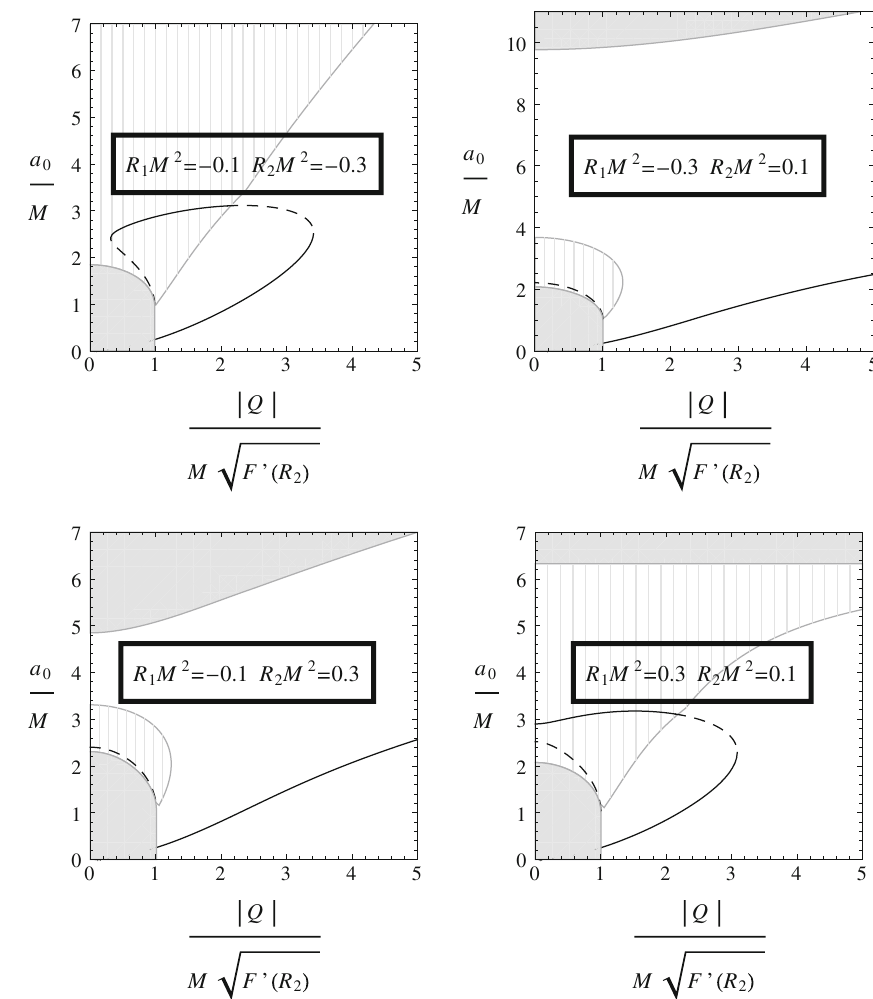
Fig. 2 Stability of bubbles in quadratic F ( R ) theories for different values of curvature scalars R 1 (inner region) and R 2 (outer region). Solid curves represent stable static solutions with radius a 0 , while dotted curves represent unstable